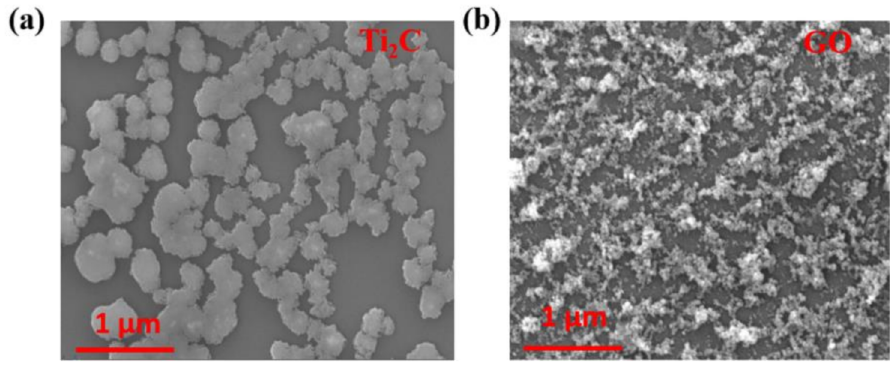
Figure 2. ( a ) Scanning electron microscopy (SEM) image of MXene (Ti 2 C) material; ( b ) SEM image of graphene oxide (GO)